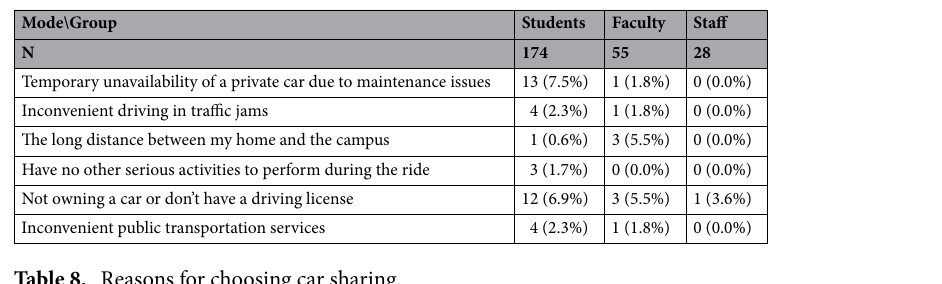
Table 8. Reasons for choosing car